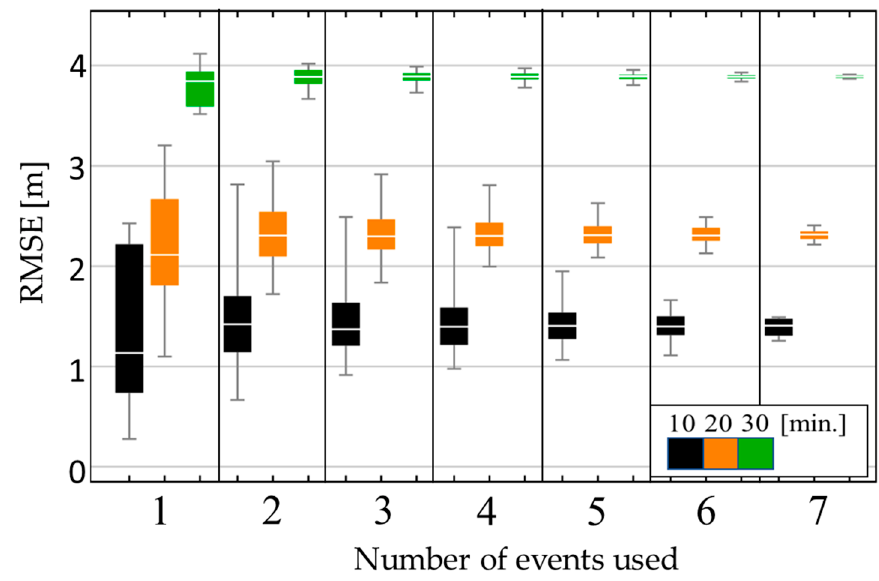
Figure 9. Differences in forecast accuracy for different numbers of flood events.